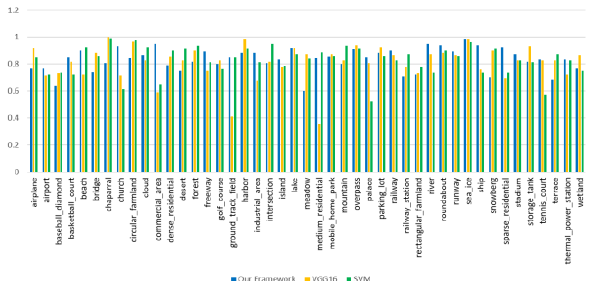
Figure 10 Comparison of the classification accuracy of each class of the two methods on the NWPU-RESISC45 dataset. Blue represents our framework. Yellow represents the VGG16 model. Green represents the SVM.